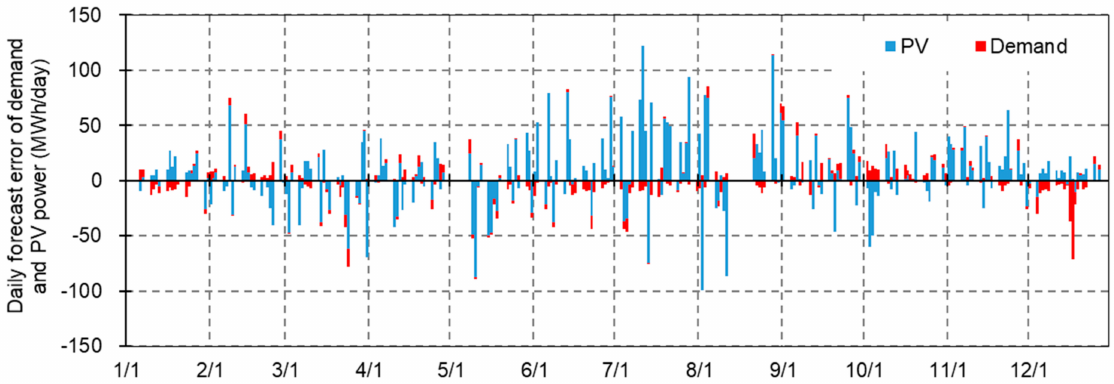
Figure 5. Daily residual load forecast error (weekdays only).